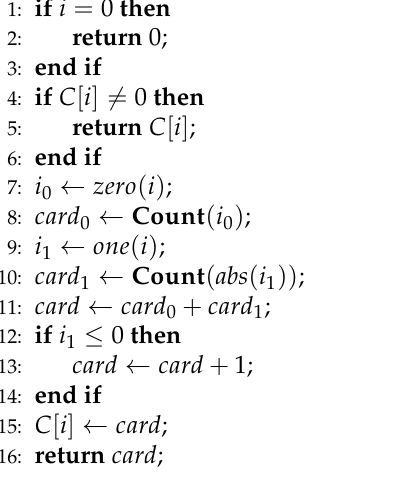
Algorithm 4 Count ( i ) : Algorithm that computes the cardinality of the family of sets represented by nodes reachable from a node i . The cardinalities are stored in an integer array C of length m , where m is the number of ZDD nodes. The initial values of all the elements in C are 0.